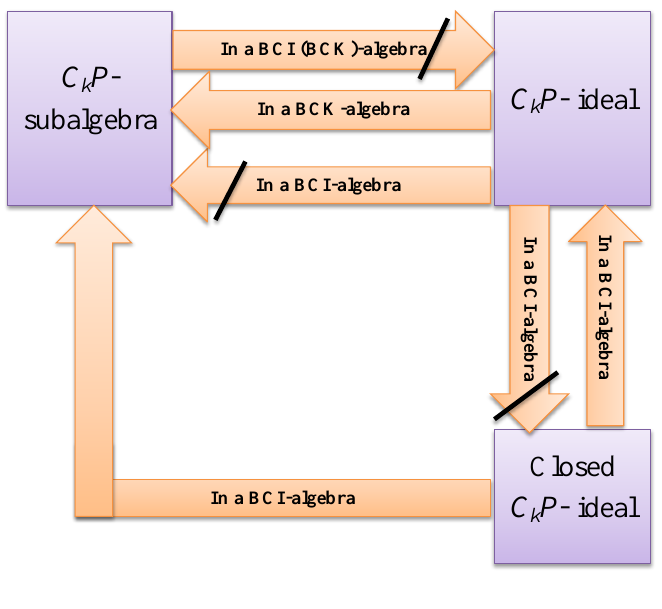
Figure 3. Algebraic relations part